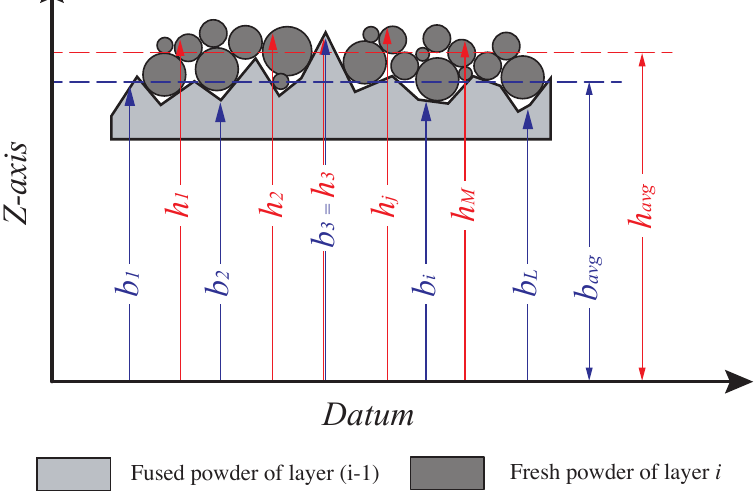
Figure 3. Schematic to understand computations of spread layer